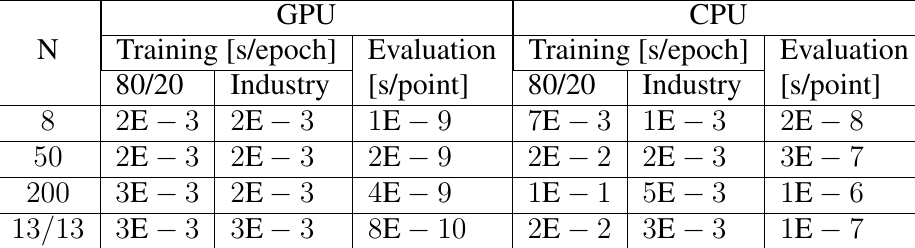
Table 5: Training and evaluation times for a single